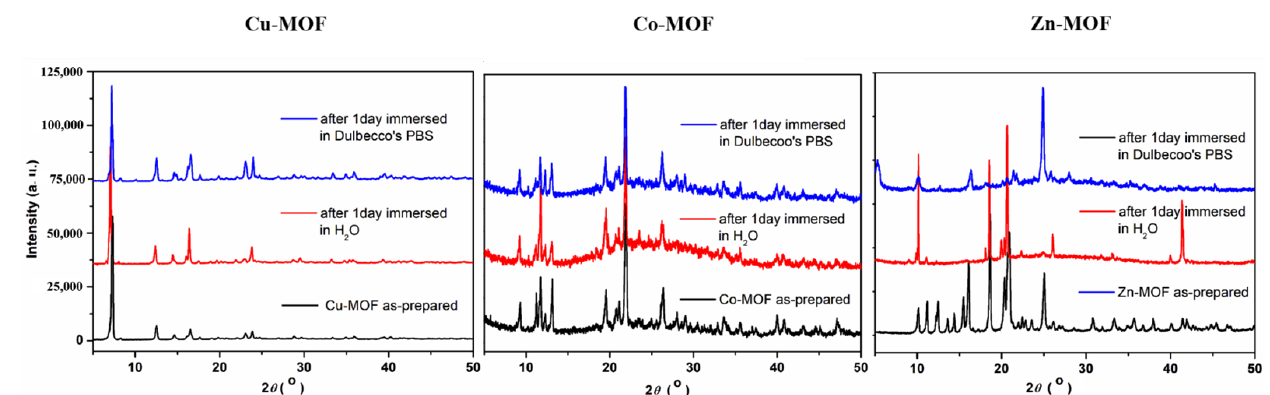
Figure 4. PXRD patterns of the Cu-MOF, Co-MOF, and Zn-MOF: as-prepared ( black ), and after immersion in H 2 O ( red ) or Dulbecco’s PBS ( blue ).